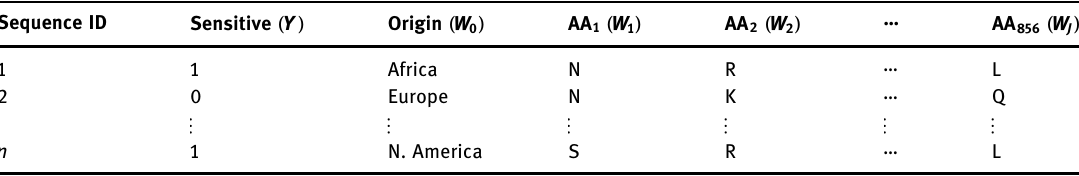
Table 1: Example data set illustrating structure of CATNAP data for a given antibody Sequence